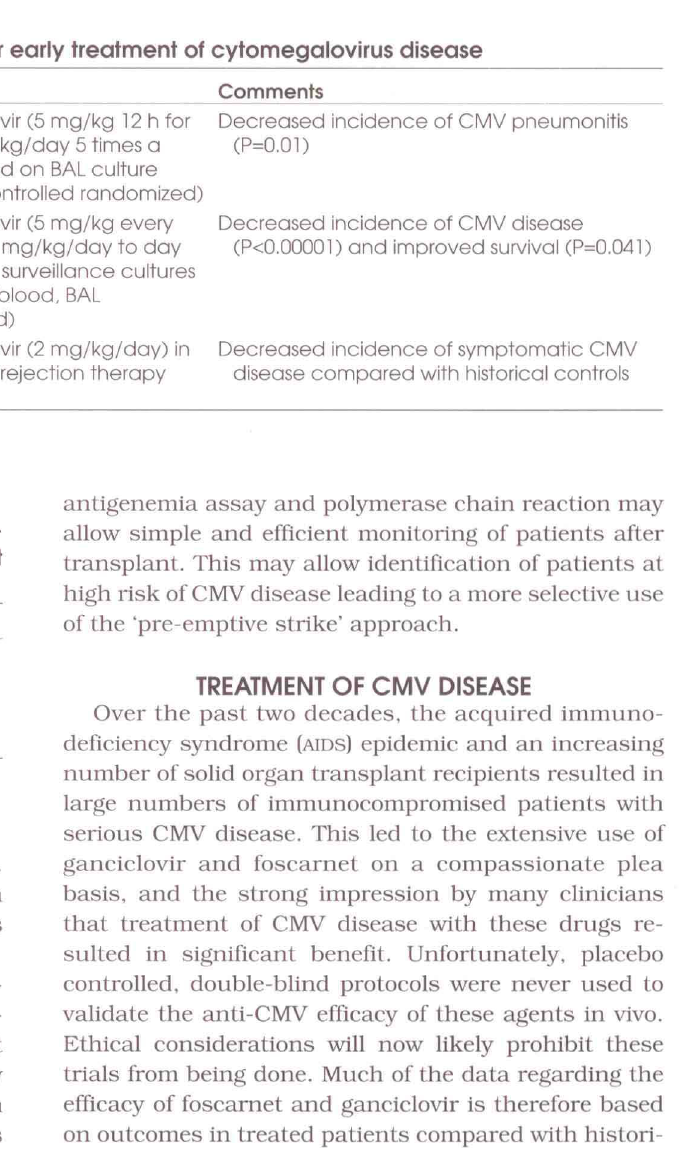
The use of the 'pre-emptive strike' for the prophylaxis or early treatment of cytomegalovirus disease Patients